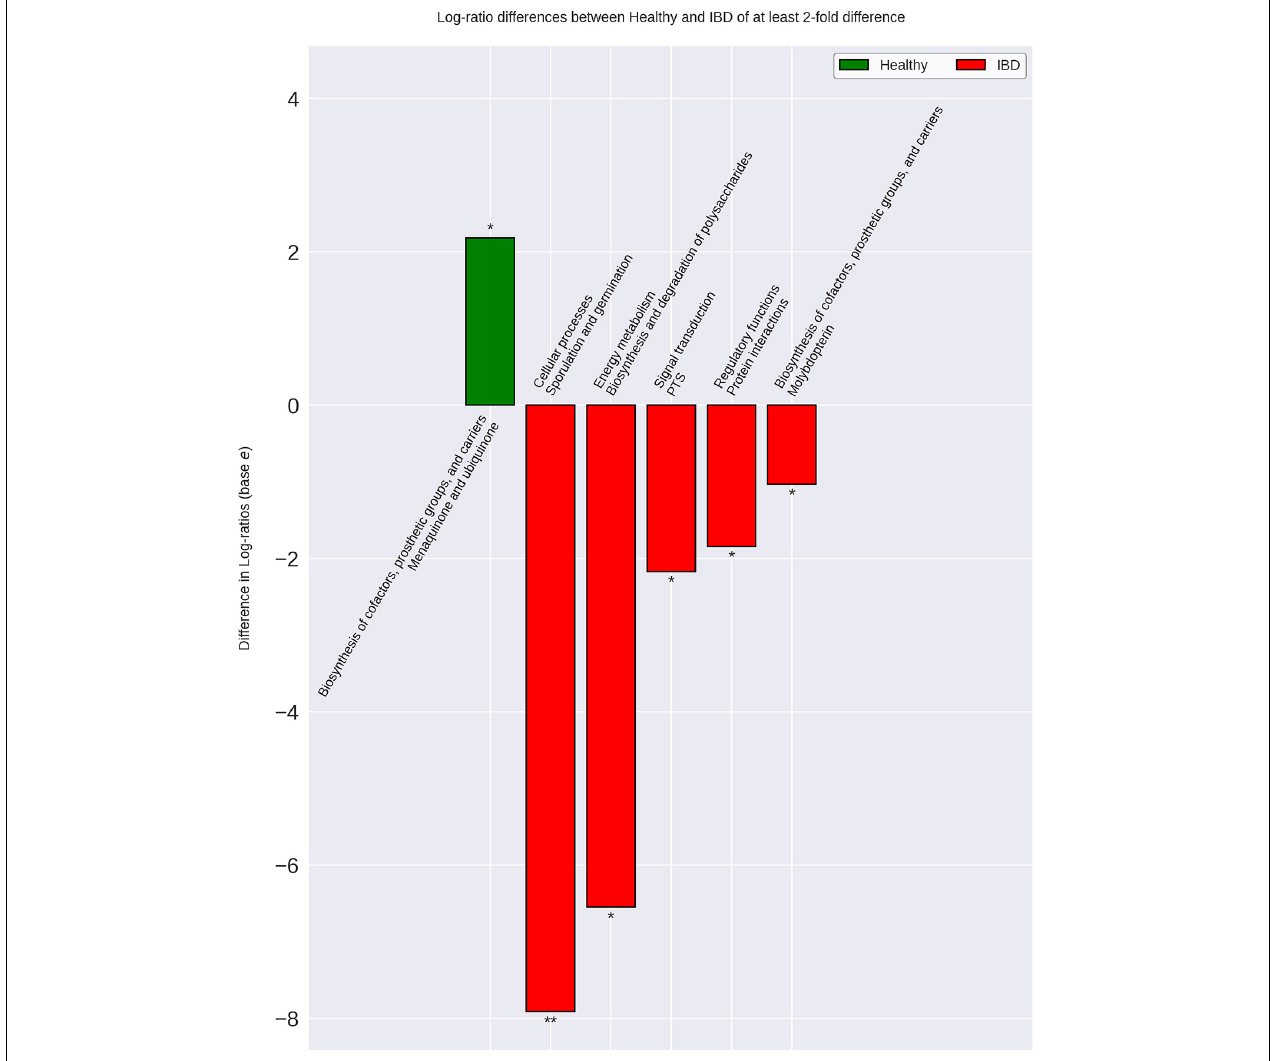
FIGURE 6 | Differences in IBD gut microbiome functional capacity. Genomic functional capacity was determined by using the TIGRFAM protein family database. The counts for each TIGRFAM within a bacterial species were weighted by the relative abundance of the bacterial species within each group. The CLR-transformed relative abundance of the TIGRFAM’s within IBD were then compared to the non-IBD, Healthy-1 cohort, and Healthy-2 cohort individually. The differentially abundant TIGRFAM’s were then summed based on their roles, according to the TIGRFAM database. There were no differences between the IBD and non-IBD gut microbiome functional capacities. There were six significantly differentially abundant protein family roles when comparing IBD to the Healthy-1 cohort that were also found in the Healthy-2 cohort. These differences are implicated in important processes that may contribute to IBD-related symptoms such as diarrhea, intestinal bleeding, and increased intestinal permeability. The relative abundances of the Healthy-1 and Healthy-2 cohort TIGRFAM roles were averaged for ease of visualization. * Indicates a p -value < 0.05. ** Indicates a p -value <